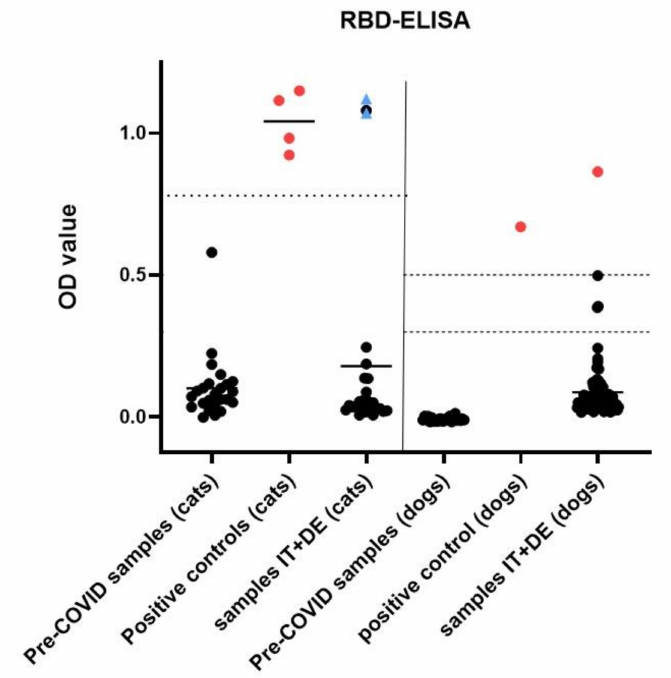
Figure 4. Results of receptor binding domain enzyme-linked immunosorbent assay (RBD-ELISA) on cat sera (left) and dog sera (right). Optical density (OD) values (measured at 415 nm) of cat samples and controls are indicated on the left half, and dog samples and controls are indicated on the right half of the figure. Samples that were confirmed as positive by the surrogate virus neutralization test (sVNT) and the University of Utrecht (S1 ELISA, S1-RBD ELISA, and pseudotyped VNT) are shown in red. The dotted line indicates the positive cut-off value for cats calculated as the six-fold standard deviation above the mean of pre-COVID-19 controls from cat sera (OD value 0.78). A positive cut-off value for dogs was not determined. Instead, samples with an OD value above 0.3 are described as suspicious, and above 0.5 as highly suspicious (dashed lines). One sample from a dog (ID 5) yielded a highly suspicious OD value of 0.86, and was confirmed to be positive by the sVNT and the University of Utrecht. Two sera collected in October and November 2020 from the RT-qPCR-positive cat (ID 234) are indicated as blue triangles (results were confirmed by sVNT and by the University of